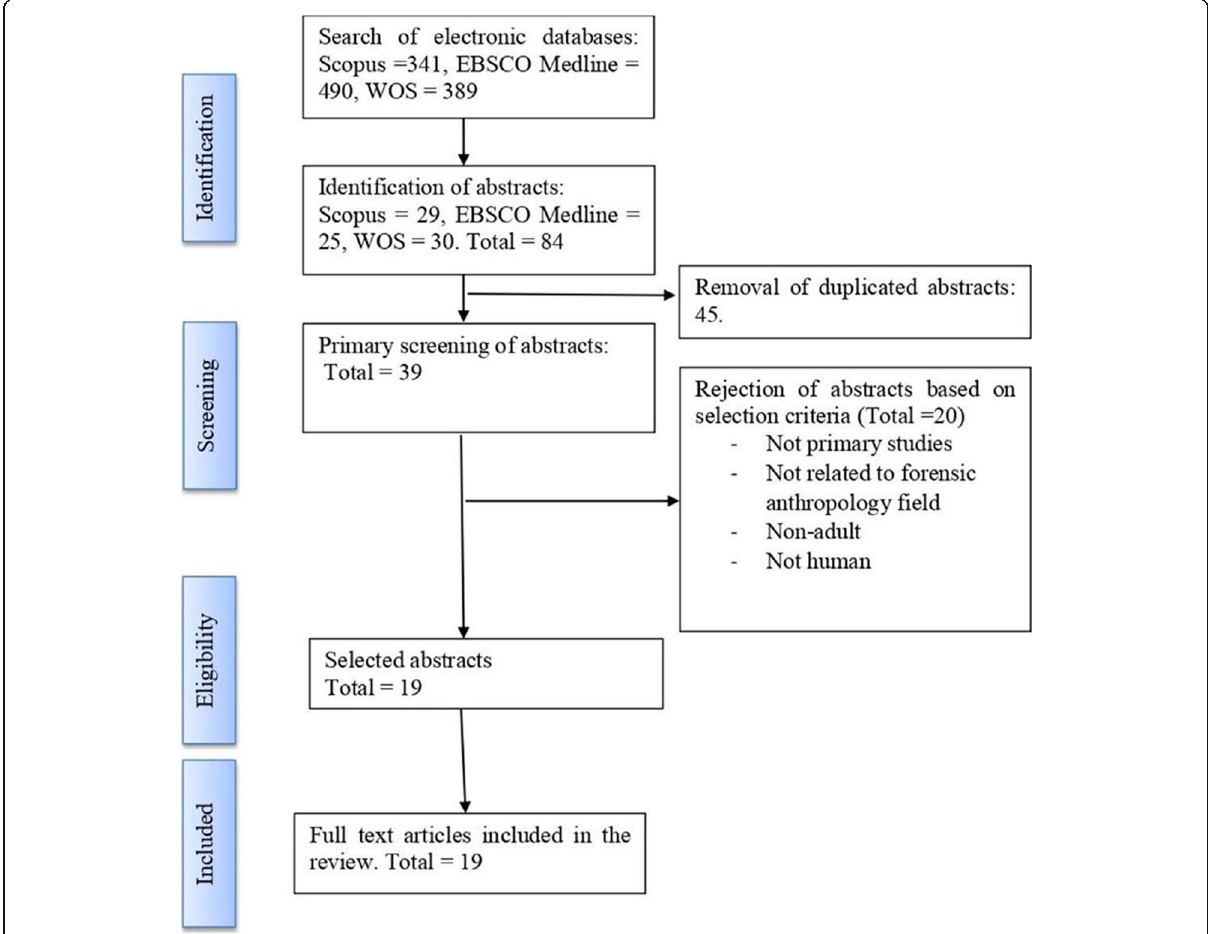
Fig. 1 The flow chart showing the selection process for systematic